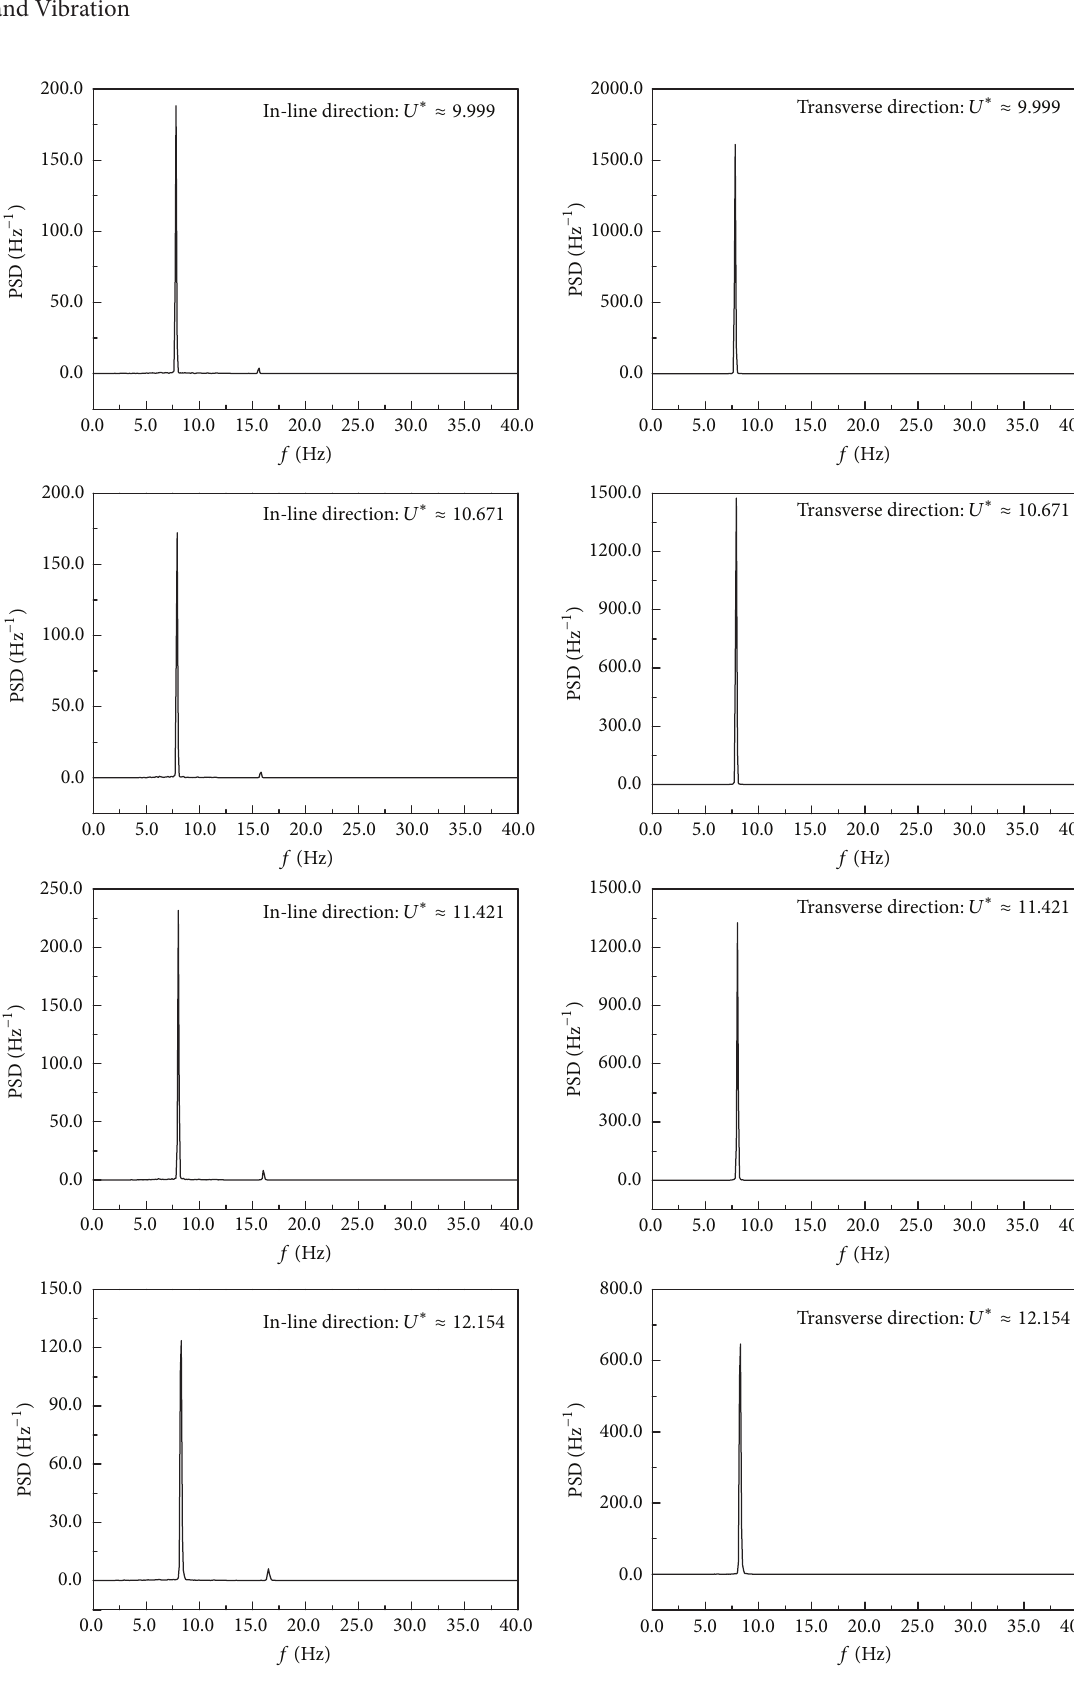
Figure 11: Power spectrum density functions of stainless steel tube vibrations with the decreasing of flow